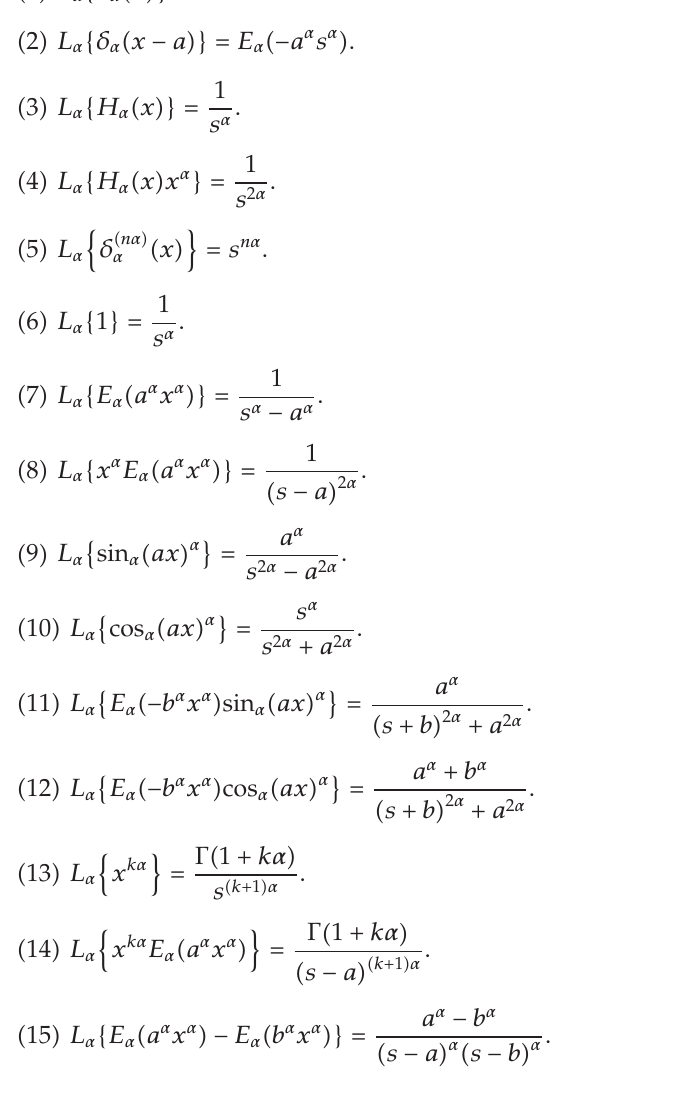
The Yang-Laplace transform is an e ff ective mathematical tool for solving local fractional di ff erential equations. Consider the following local fractional di ff erential